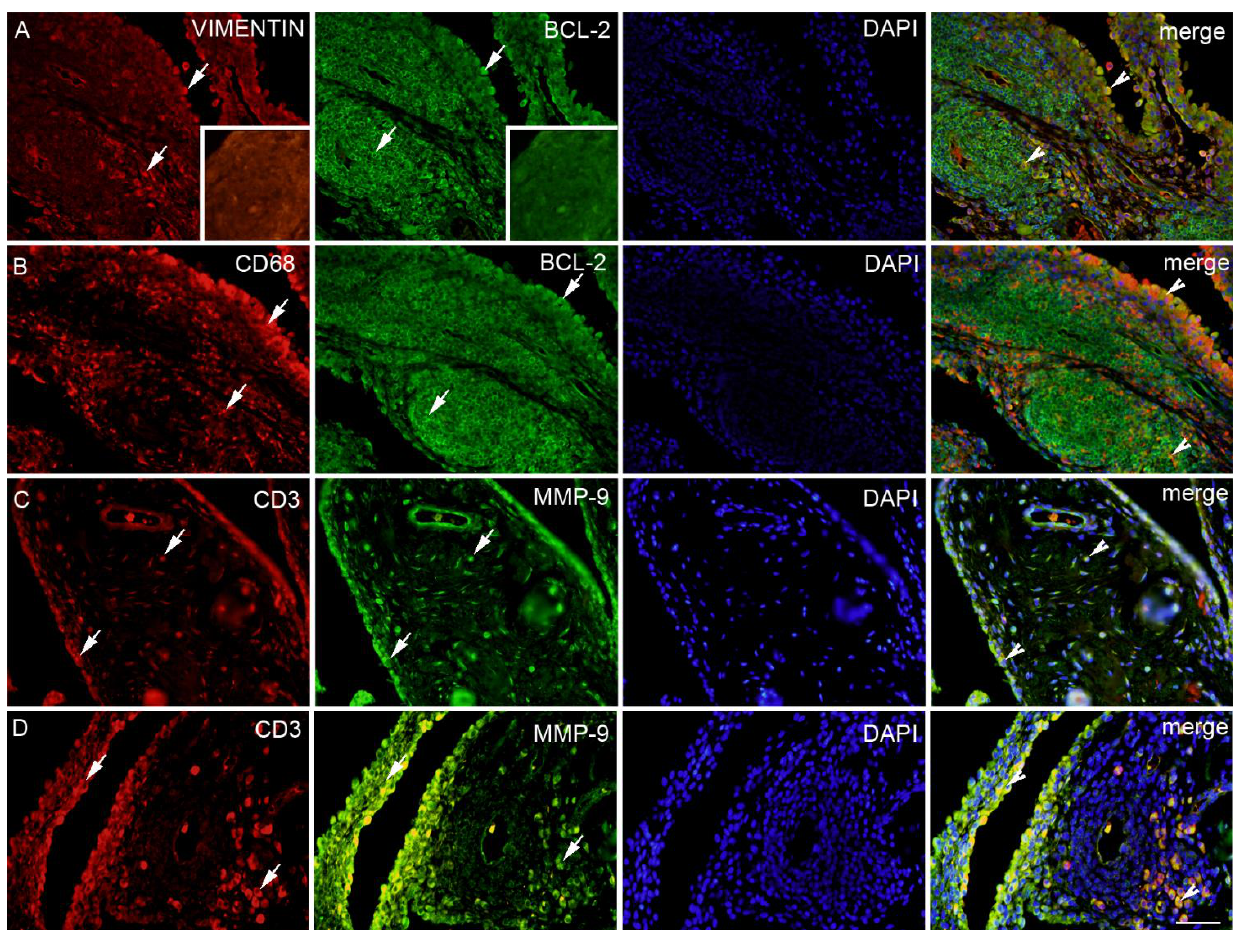
Figure 5. Synovial membrane of patients with hip osteoarthritis (HOA). Vimentin (red) fibroblasts and BCL-2 (green) positive cells in the intima and subintima (arrows); DAPI (blue) nuclear staining; co-localization of VIMENTIN and BCL-2 merged with DAPI nuclear staining is displayed in the intima and lymph node (arrowheads) in the far-right column (merge); severe HOA ( A ). CD68 (red) macrophages and BCL-2 (green) positive cells in the intima and subintima (arrows); DAPI (blue) nuclear staining; Co-localization of CD68 and BCL-2 merged with DAPI nuclear staining are displayed in the intima and lymph node (arrowheads) in the far-right column (merge); severe HOA ( B ). CD3 (red) and MMP-9 (green) positive cells in the intima and subintima (arrows); DAPI (blue) nuclear staining; co-localization of CD3 and MMP-9 merged with DAPI nuclear staining is displayed in the intima and subintima (arrowheads) in the far-right column (merge) in the moderate HOA ( C ). CD3 (red) and MMP-9 (green) positive cells in the intima and subintima (arrows); DAPI (blue) nuclear staining; co-localization of CD3 and MMP-9 merged with DAPI nuclear staining is displayed in the intima and lymph node (arrowheads) in the far-right column (merge) in the severe HOA ( D ). Inset: negative control of the lymph node. Magnification ×40, scale bar = 80 µm.